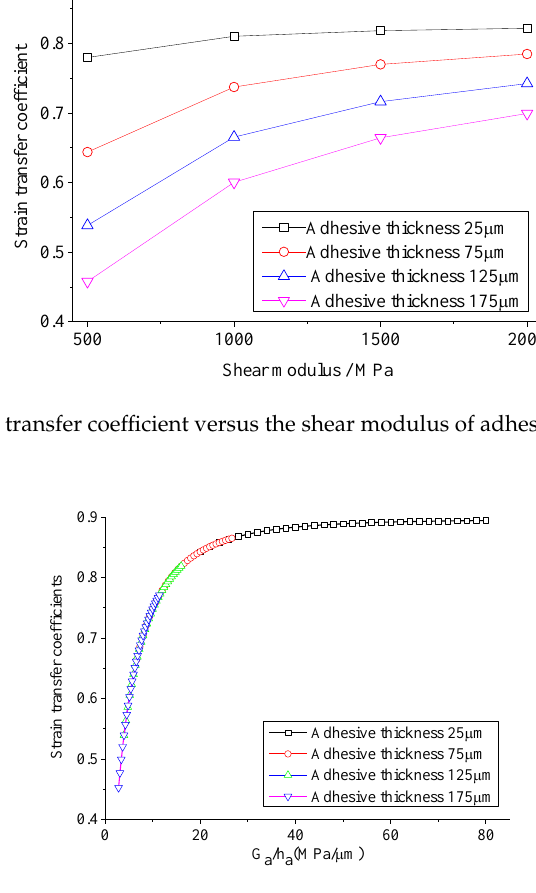
Figure 6. The strain transfer coefficient versus the shear modulus of adhesive in the theoretical model.